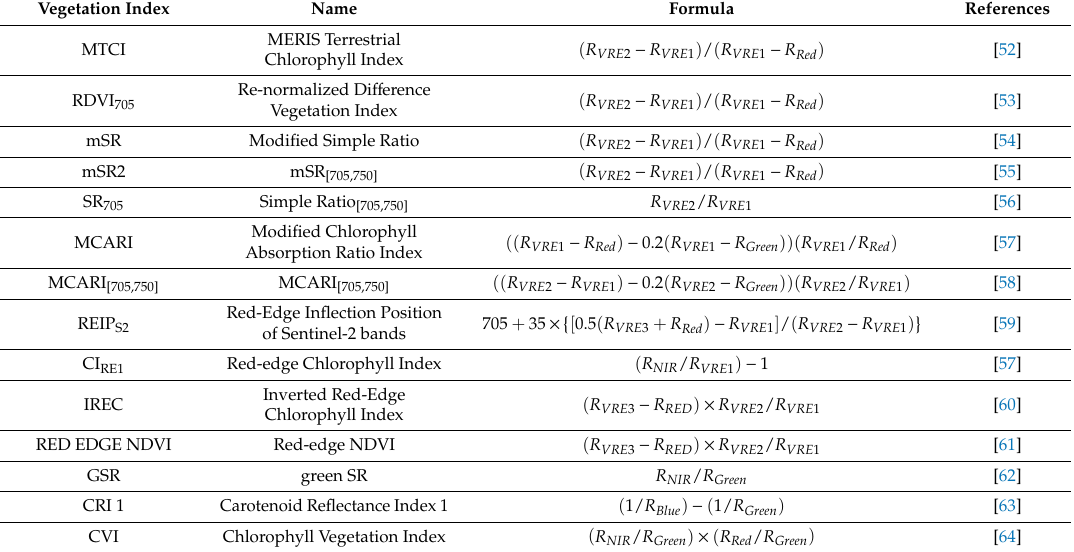
Table 4. Calculation formulas of the vegetation